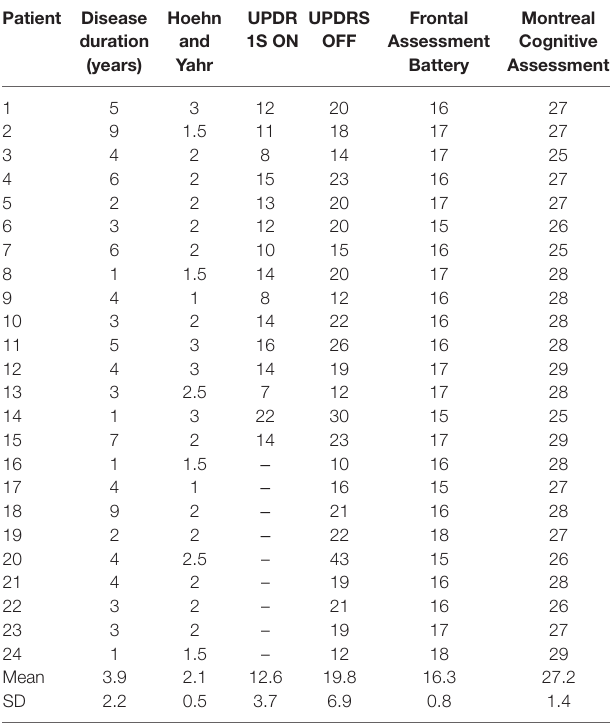
Table 1 | Clinical and demographic features of patients with Parkinson’s